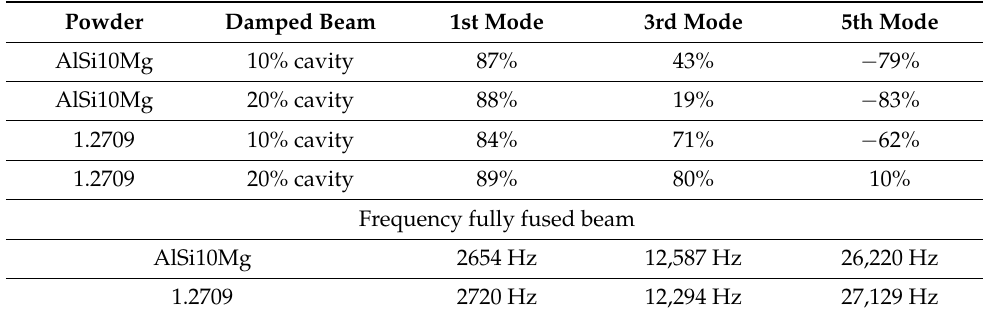
Figure 11. Force-dependent damping characteristics 5th mode, outer dimensions: 8.4 × 8.4 × 169 mm 3 , parameter 43–45, material: 1.2709. Table 5. Amplitude reduction of the FRF and natural frequencies related to Figure